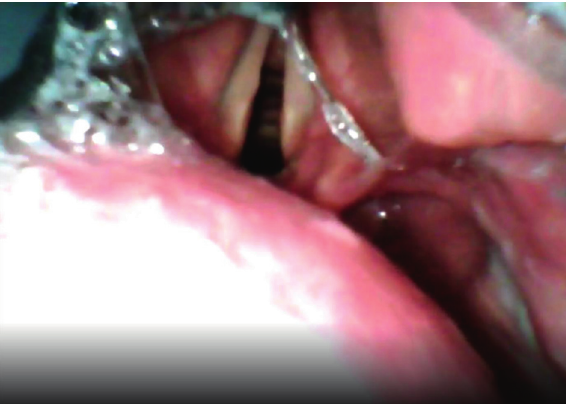
Figure 2: View on awake videolaryngoscopy.